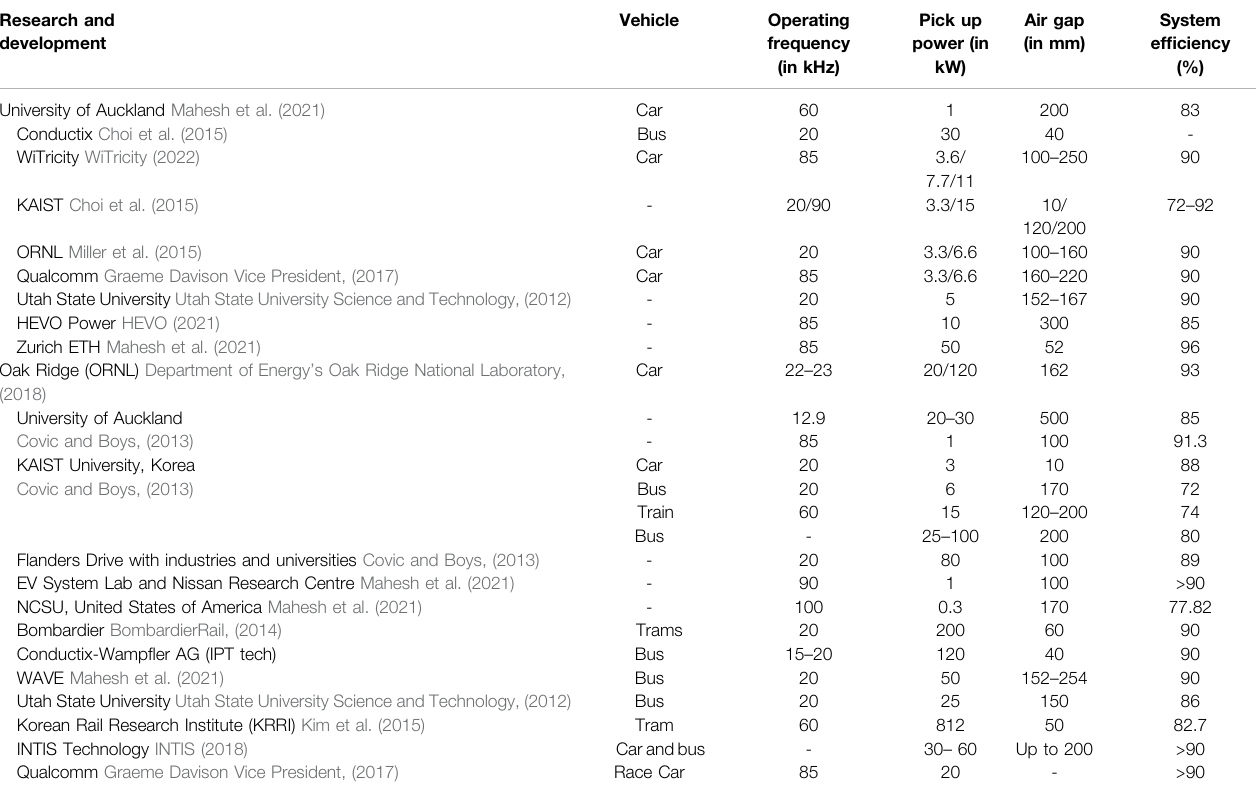
TABLE 1 | Development of Static wireless charging (SWC) technologies. Development of DWC technologies. Research and